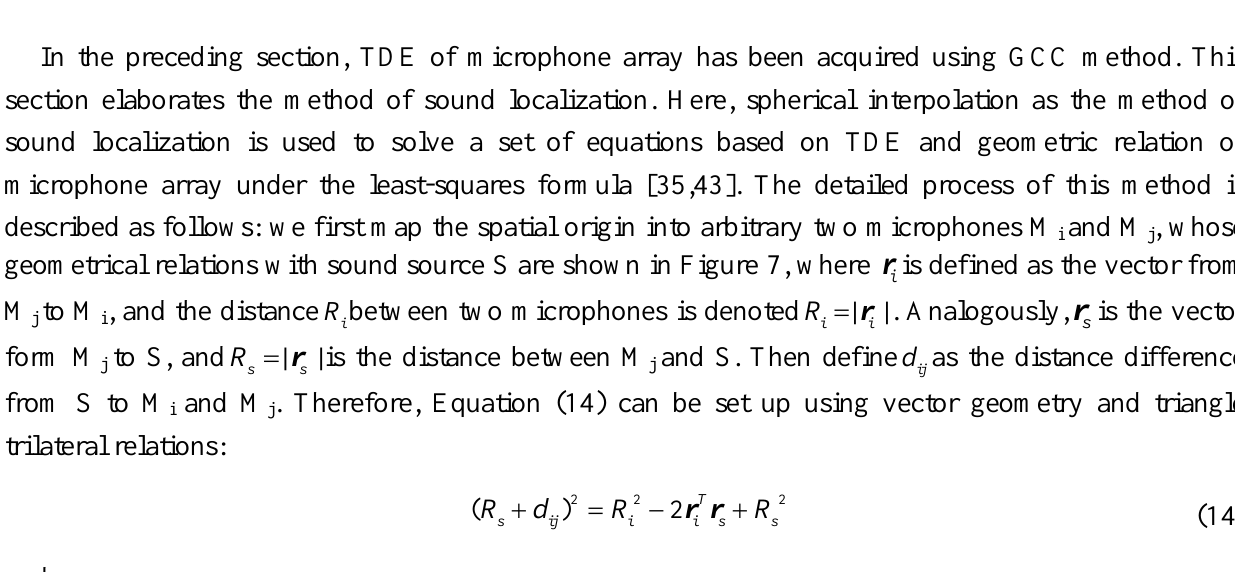
Figure 7. Geometry relations among M